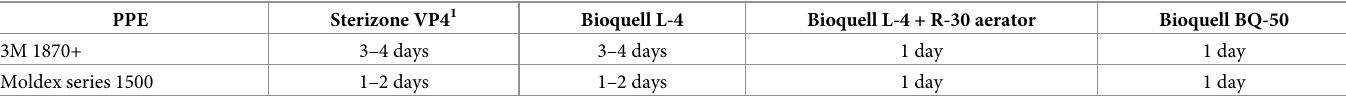
Table 3. Aeration time required to achieve FFRs hydrogen peroxide emissions below 0.1 ppm a,b .